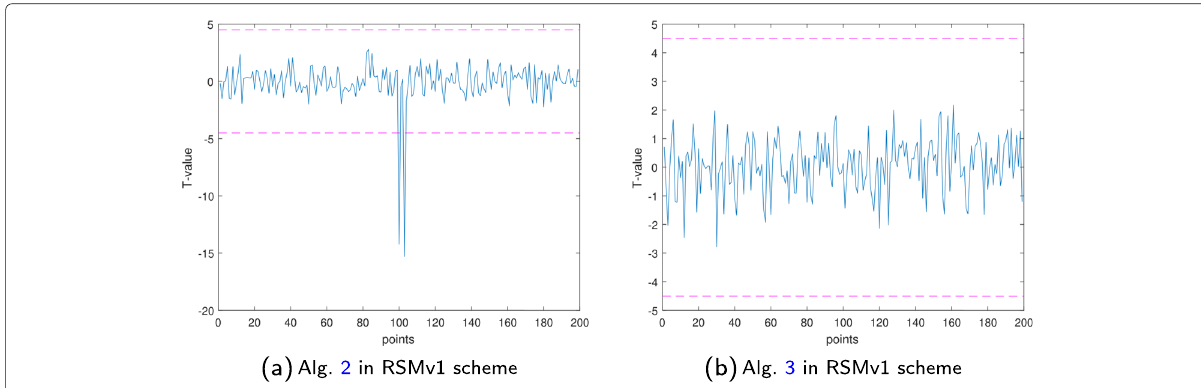
Fig. 5 T-test on simulated leakages of Algorithm 2 and Algorithm 3 in RSMv1